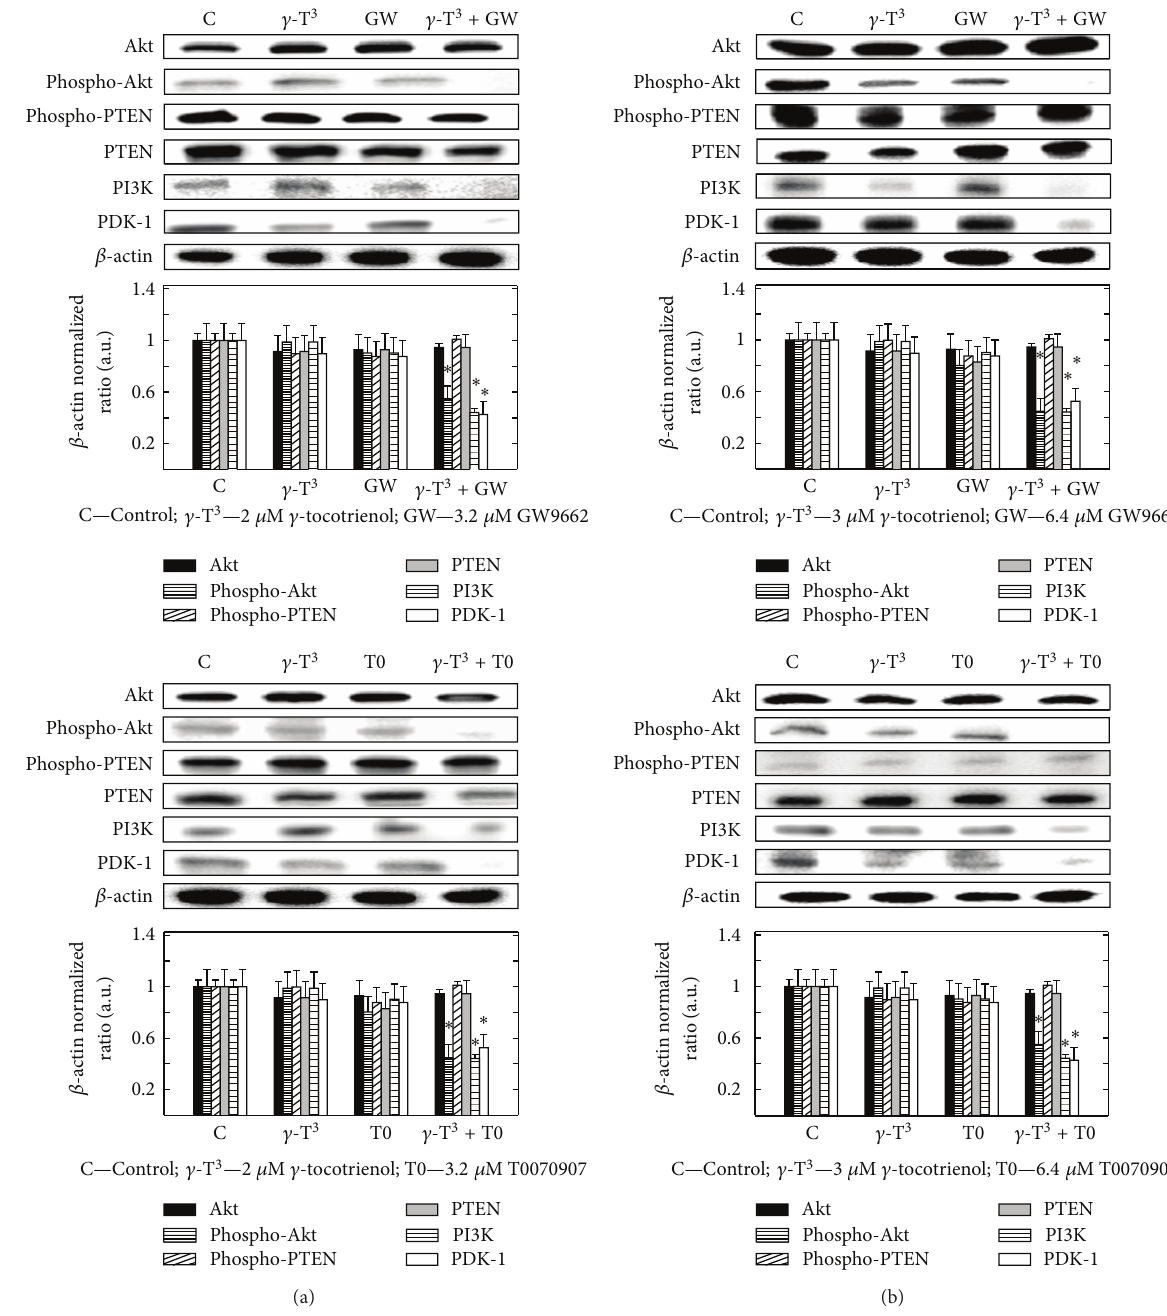
F 10: Western blot analysis of -tocotrienol and PPAR antagonists (GW9662 or T0070907) alone or in combination on Akt, phospho- Akt, PTEN, phospho-PTEN, PI3K, and PDK-1 levels on (a) MCF-7 and (b) MDA-MB-231 cells. MCF-7 cells were initially plated at cells/100mm culture dish and treated with control or treatment media containing 2 𝛾𝛾 𝛾𝛾